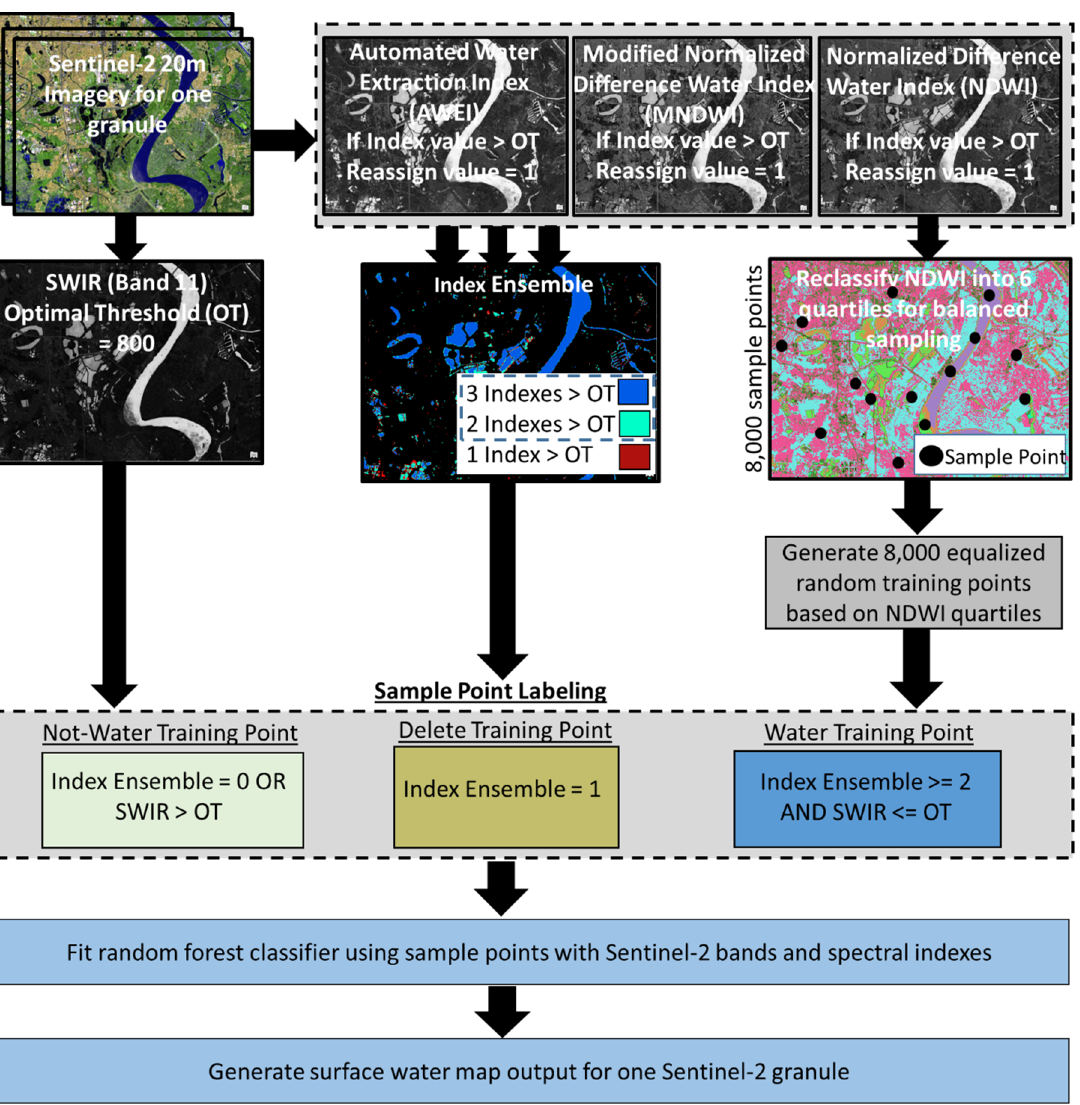
Figure 2. Methodology for 20 m Sentinel-2 automated training data generation and initial surface water extent map generation. The preliminary set of maps are generated with a standard zero threshold for the indexes and 850 BoA reflectance threshold for SWIR1 band. Ground-truth points are generated on this initial set of maps and then used to determine the Optimal Thresholds (OT) for the spectral indexes and SWIR band. The OTs are used to create the final surface water maps.